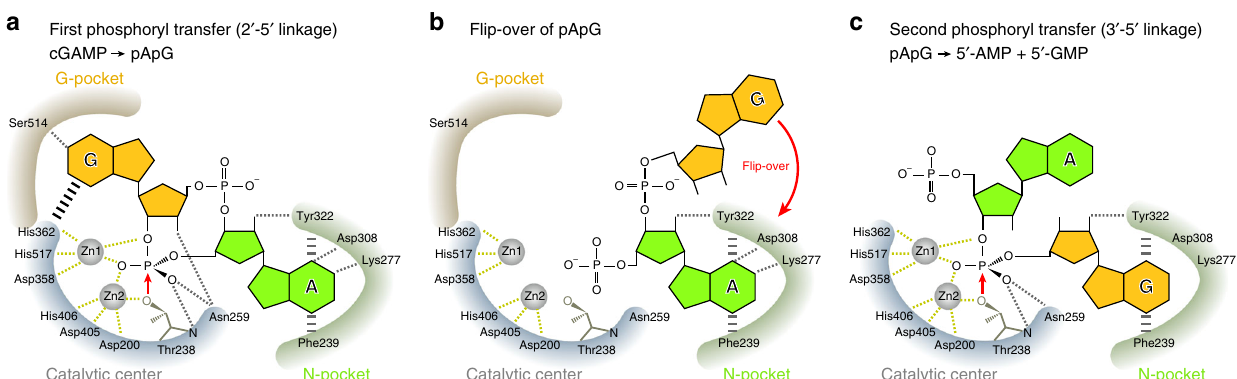
Fig. 5 Proposed mechanism of the ENPP1-catalyzed 2 ′ 3 ′ -cGAMP degradation. a ENPP1 accommodates the adenine and guanine bases of 2 ′ 3 ′ -cGAMP in the N-pocket and G-pocket, respectively. The Thr238 O γ atom nucleophilically attacks the phosphorus atom in the 2 ′ -5 ′ phosphodiester linkage, resulting in the production of the pApG intermediate. b The pApG intermediate is fl ipped over, and the guanine base of pApG is then accommodated in the N-pocket. c The 3 ′ -5 ′ phosphodiester linkage of pApG is hydrolyzed to produce 5 ′ -AMP and 5 ′